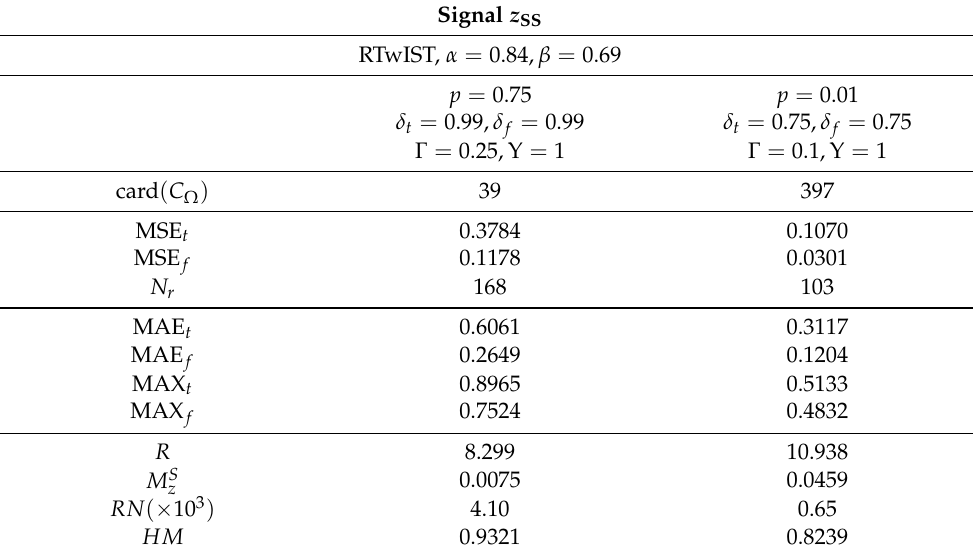
Figure 5. Reconstructed sparse TFDs based on the RTwIST algorithm for the considered test signal z SS , with α = 0.84, β = 0.69 and: ( a ) p = 0.75, δ t = 0.99, δ f = 0.99, Γ = 0.25, Υ = 1; ( b ) p = 0.1, δ t = 0.75, δ f = 0.75, Γ = 0.1, Υ = 1. Table 1. Comparison of the oversparse and low-resolution